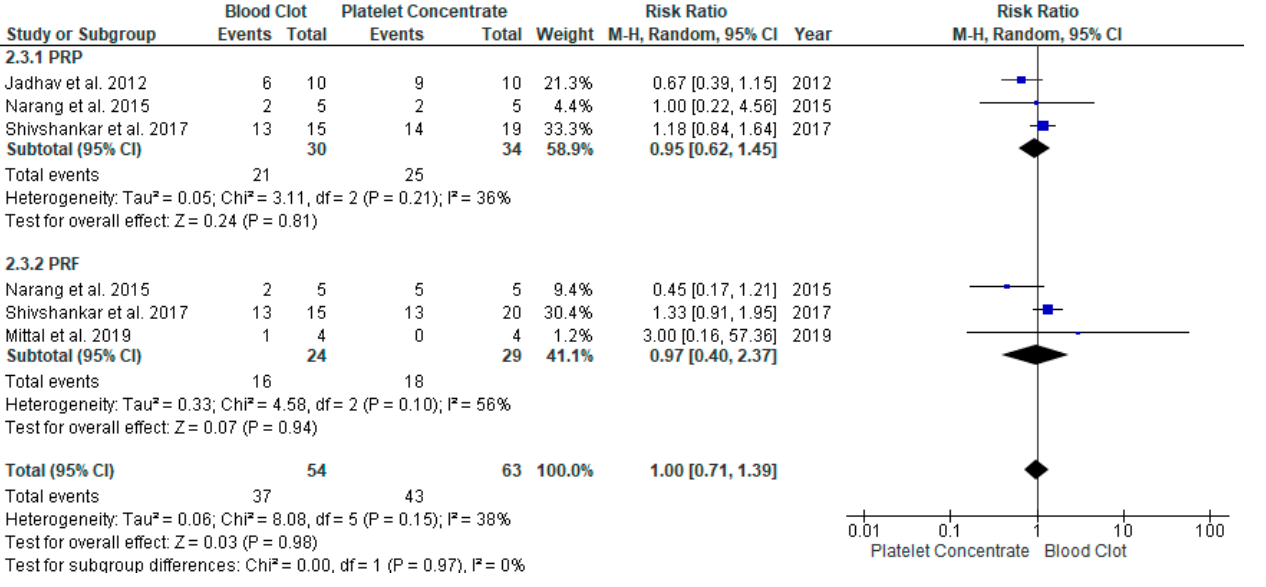
Figure 5. Meta-analysis of increased root length (IRL) in regenerative endodontic procedure (REP) using APC or BC.